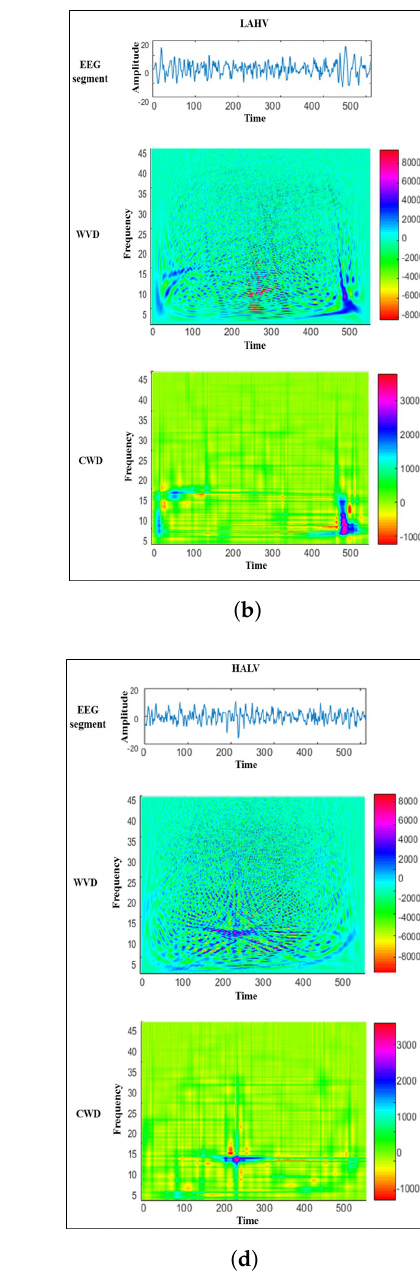
Figure 2. Top view images of the constructed time-frequency representations (TFRs) for four EEG segments that are labeled using the 2D-4CLS. ( a ) The Wigner–Ville distribution (WVD)- and Choi–Williams distribution (CWD)-based TFRs computed for an EEG segment that belongs to the HAHV emotion class. ( b ) The WVD- and CWD-based TFRs computed for an EEG segment that belongs to the LAHV emotion class. ( c ) The WVD- and CWD-based TFRs computed for an EEG segment that belongs to the LALV emotion class. ( d ) The WVD- and CWD-based TFRs computed for an EEG segment that belongs to the HALV emotion class. The time axis represents the indices of the samples within the EEG segment, while the frequency axis represents the frequency components within the EEG segment. The color map located to the right of each plot represents the values of the computed WVD and CWD at each point in the time-frequency